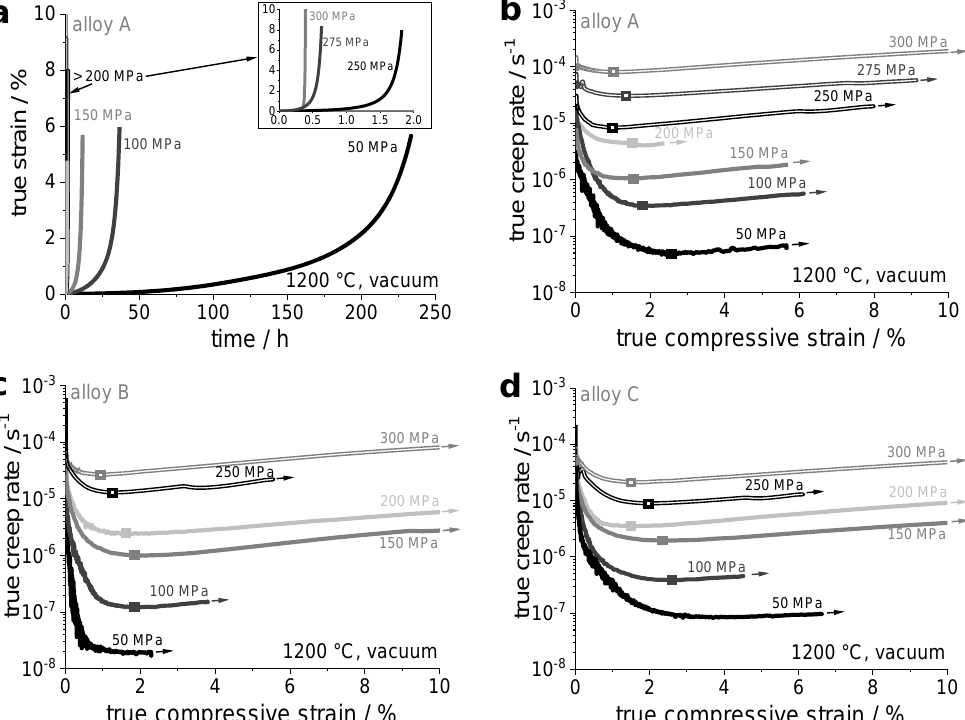
Figure 6. Compression creep testing at 1200 °C under vacuum: True creep strain vs. time for alloy A ( a ), creep rate vs. true strain for the alloys A ( b ), B ( c ) and C ( d ). The creep rate minima are highlighted by square markers.